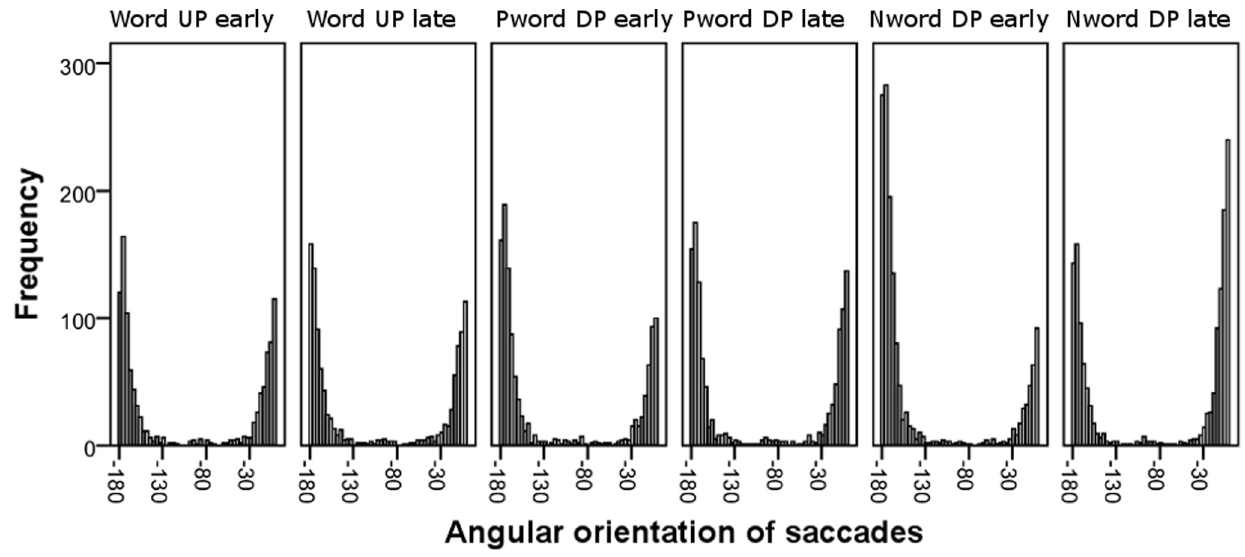
Figure 3. The spatial distribution of saccade orientation on a horizontal axis. The values range from 0 (right) to -180 (left) directions.